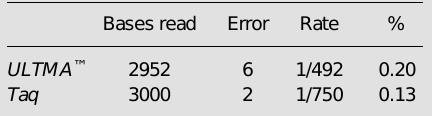
Table 2 - Comparison of the error frequencies obtained with ULTMA ™ and Taq polymerases. Fisher’s exact test (P = 0.4) shows that the differ- ences were not statistically significant. Errors were differences from the known HXB2-HIV-1 se- quence after 35 cycles for each round of nested